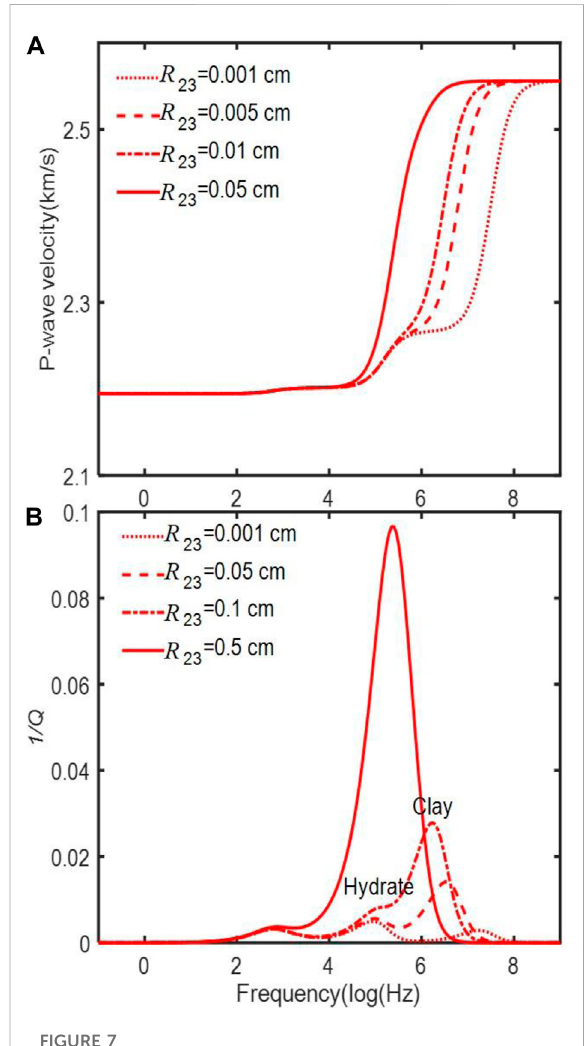
Effect of the hydrate inclusion radius on the P-wave velocity dispersion (A) and attenuation (B) . The radius of the clay inclusion is R 23 = 0.005 cm, and the rock porosity is ϕ =